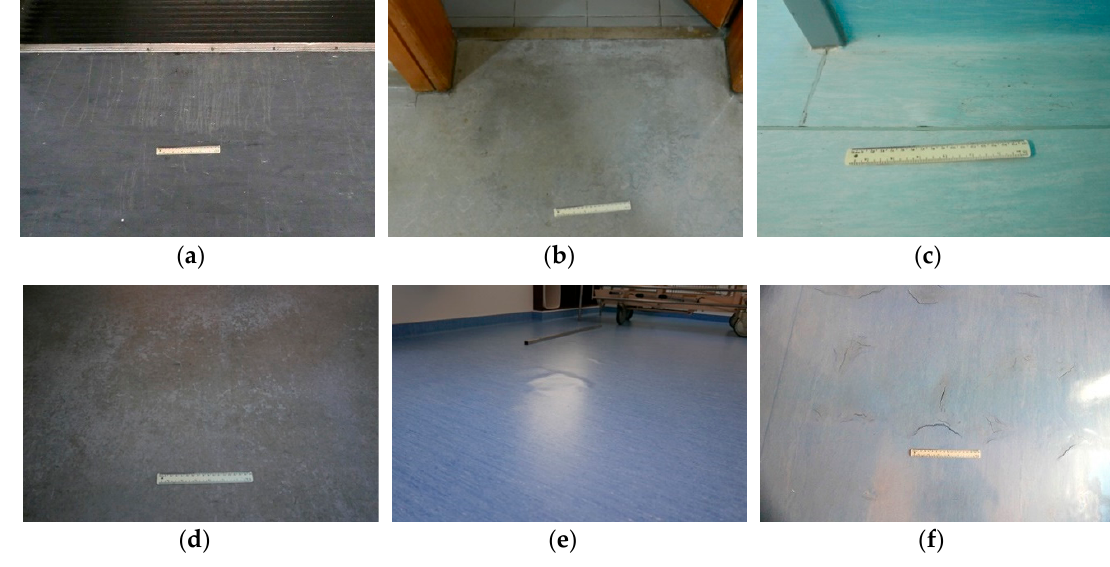
Figure 4. Anomalies: ( a ) A-A1 scratches; ( b ) A-A1 wear; ( c ) A-A3 brightness changes; ( d ) A-A3 brightness changes on a linoleum flooring due to an inadequate maintenance; ( e ) A-B2 peeling, requiring the use of repair technique R-B2 partial replacement; ( f ) A-B3 depression/settlement, requiring the use of repair technique R-B1 total replacement.